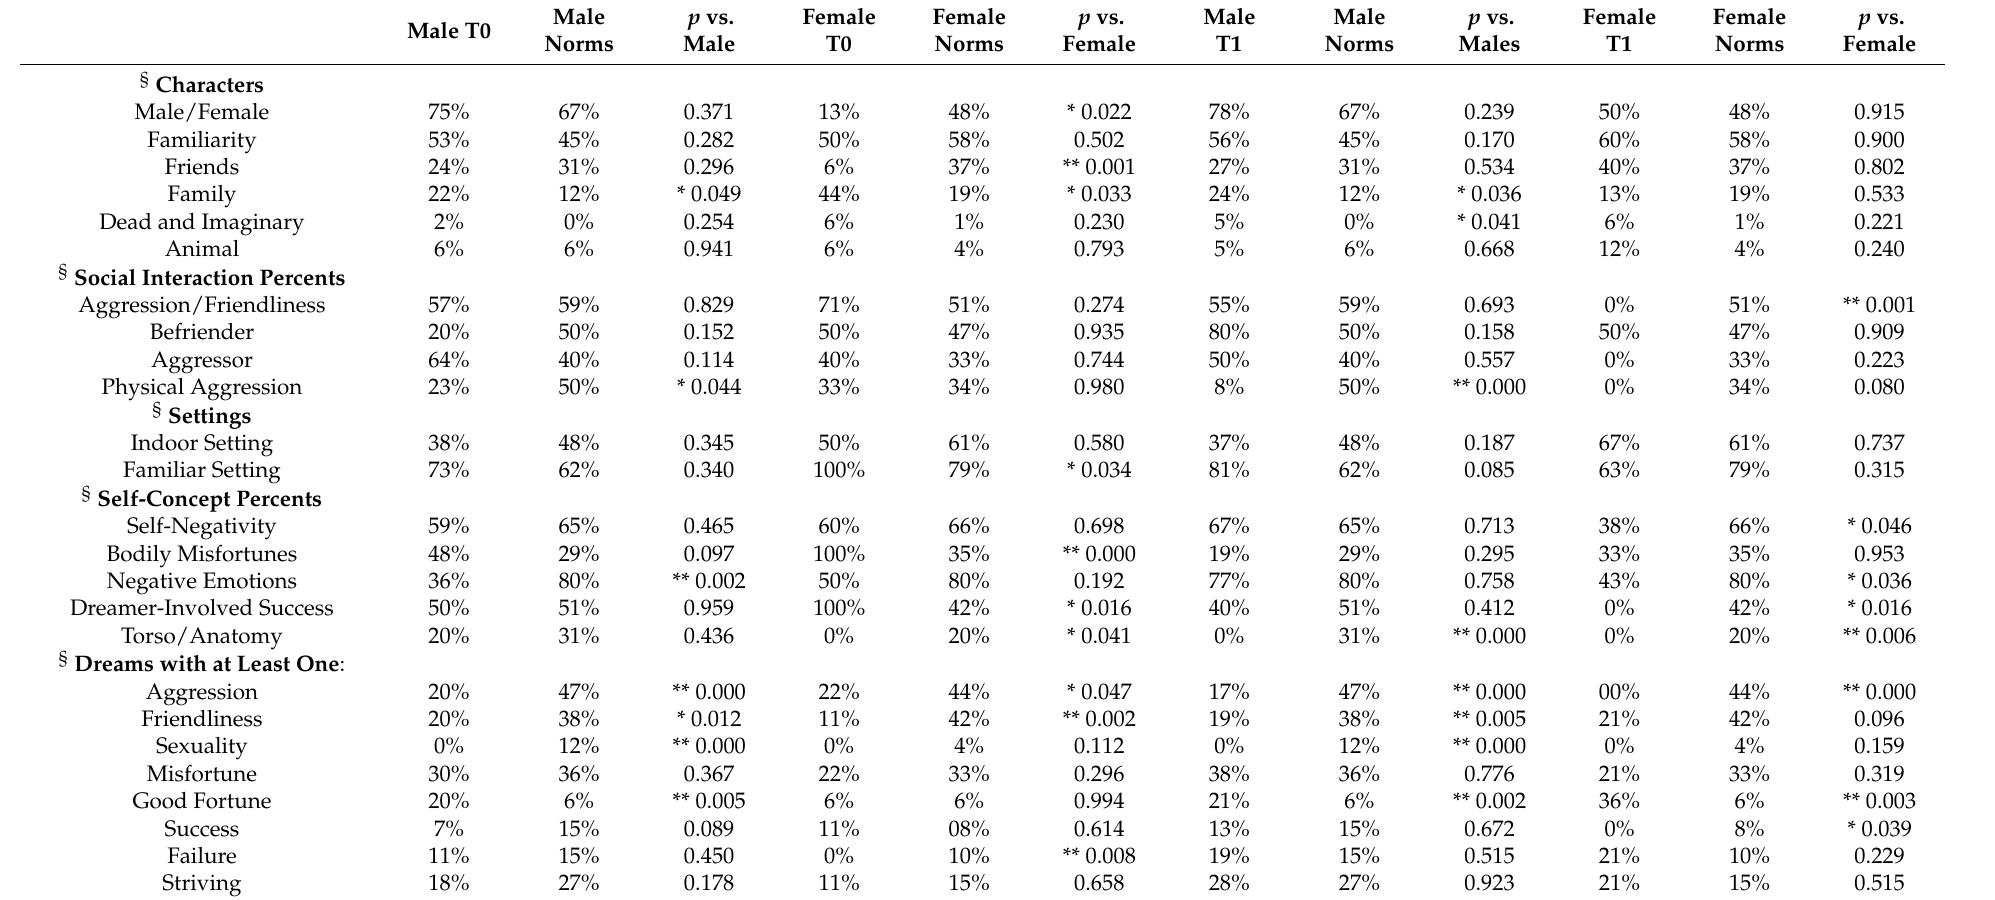
Table 2. Male at T0 vs. norms and Female at T0 vs. norms and Male at T1 vs. norms and Female at T1 vs. norms. p vs. Male Male T0 Norms